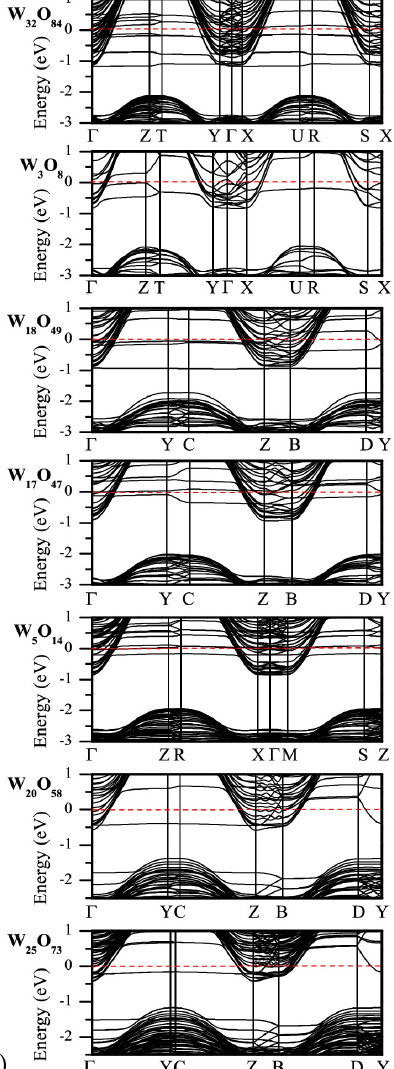
Figure 1. Crystal structure of Magnéli phases ( a ) and corresponding band structures ( b ). Reprinted from [23], with the permission of AIP Publishing,